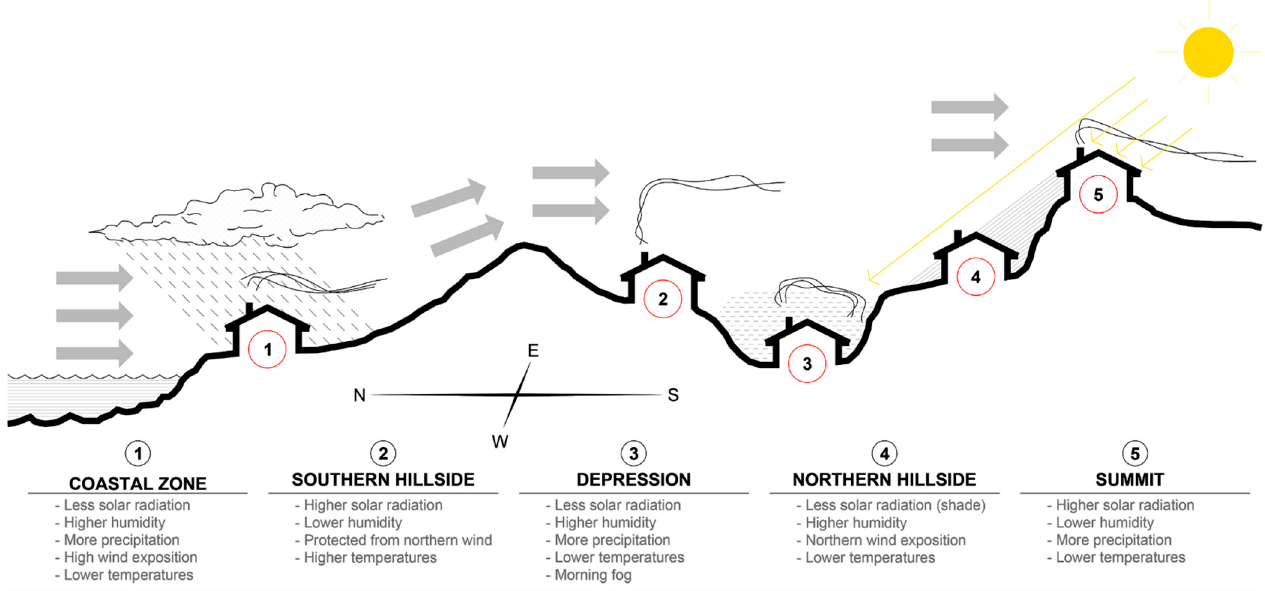
Figure 12. Typical bioclimatic implications of building location in the coastal Basque Country. Source: authors, adapted from [90].